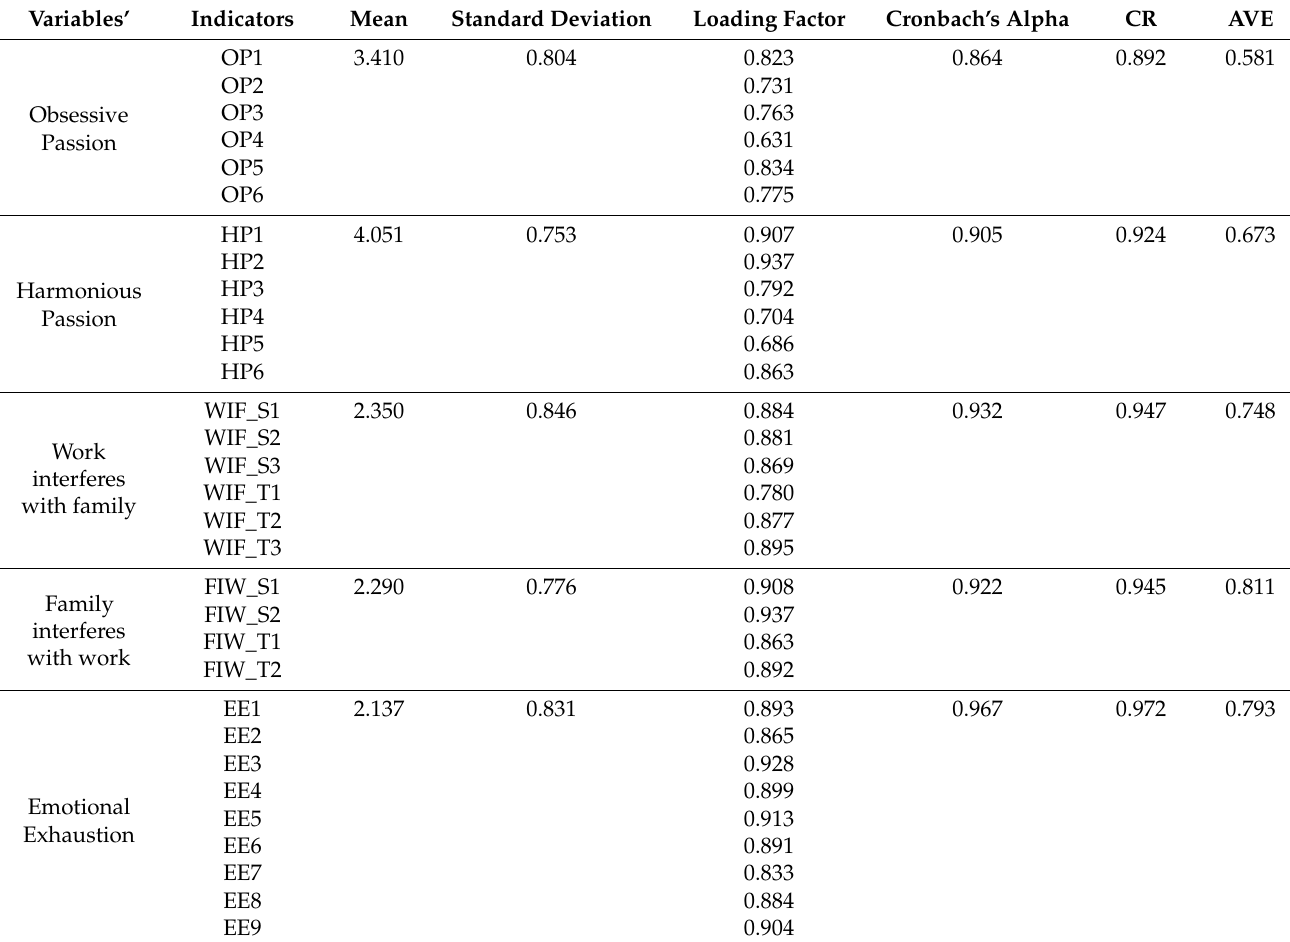
Table 2. The validity and reliability